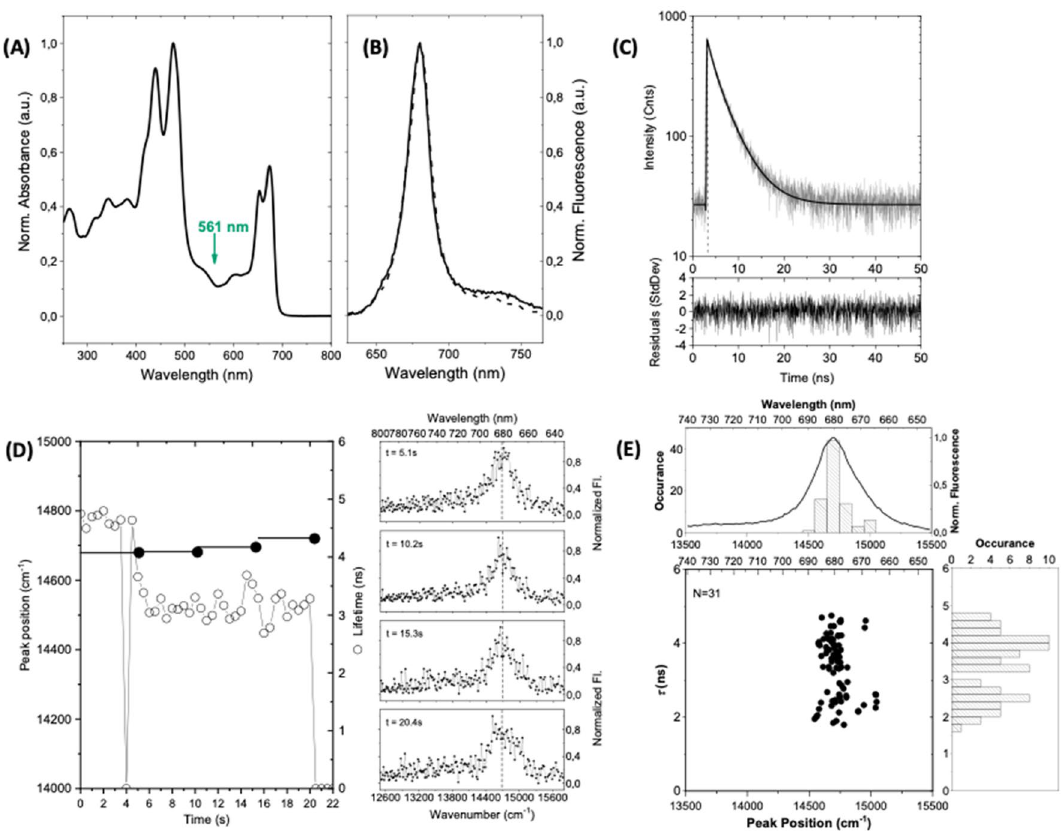
Figure 2. Spectroscopy on ensembles and single SCP complexes. The samples for spectroscopy have been prepared under ambient conditions (protocol 1). ( A ) Room temperature absorption spectrum of an ensemble of SCP complexes dissolved in bulk buffer solution at a concentration of 1.45 × 10 –7 M. ( B ) Peak normalised emission spectra from the bulk buffer solution for an excitation intensity of 30 μW/cm 2 (full line) and from an ensemble of SCP complexes embedded in a thin film of PVA (dashed line) for an excitation intensity of 525 W/cm 2 . The excitation wavelength for recording the emission spectra was 561 nm as indicated by the green arrow in ( A ). ( C ) Fluorescence lifetime of an ensemble of SCP complexes immobilized in PVA in semi- logarithmic representation. The full line corresponds to a biexponential fit (see residuals at the bottom) with decay components (amplitudes) of 4.0 ns (85%) and 1.2 ns (15%). The excitation wavelength is 561 nm and the excitation intensity amounts to 525 W/cm 2 . ( D ) Fluorescence lifetimes and spectral peak positions of a single SCP complex. The fluorescence lifetime (scale on the right) was read out every 500 ms and is given by the open dots. The drop out after 4 s presumably results from unresolved blinking. The bin time for recording the spectra was 5.1 s (full line) and the observed spectral peak position of the accumulated spectrum is given by the black dot (scale on the left). The sequence of emission spectra is shown on the right-hand side from top to bottom. For better comparison, the broken vertical line refers to the spectral peak position of the ensemble emission spectrum. ( E ) Two-dimensional representation of the fluorescence lifetime vs. spectral peak position of individual SCP complexes. Due to fluctuations of both lifetime and/or spectral peak position a single complex can contribute more than one data point to the diagram. The number of individual complexes that contribute to the pattern is given in the top left corner. The histograms correspond to the distributions of the spectral peak position (top) and fluorescence lifetime (right). For ease of comparison an ensemble emission spectrum has been overlaid in the top histogram. The statistical parameters of the two histograms (mean ± sdev) are (14,723 ± 109) cm −1 for the peak positions, and (3.4 ± 0.8) ns for the lifetimes,